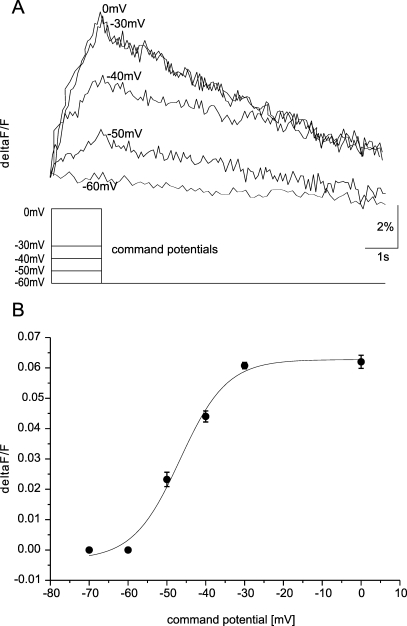
Voltage Dependence of the Calcium Signal(A) Acutely isolated DUM neurons are maintained in calcium-free saline containing TTX and TEA, and clamped to a holding potential of −60 mV followed by command potentials of −50, −40, −30, and 0 mV. The amplitudes of the resulting intracellular calcium signals change as a function of the command potential.(B) Percent change (means and standard deviations from three neurons) in intracellular calcium levels (y-axis) plotted as a function of command voltage (x-axis).